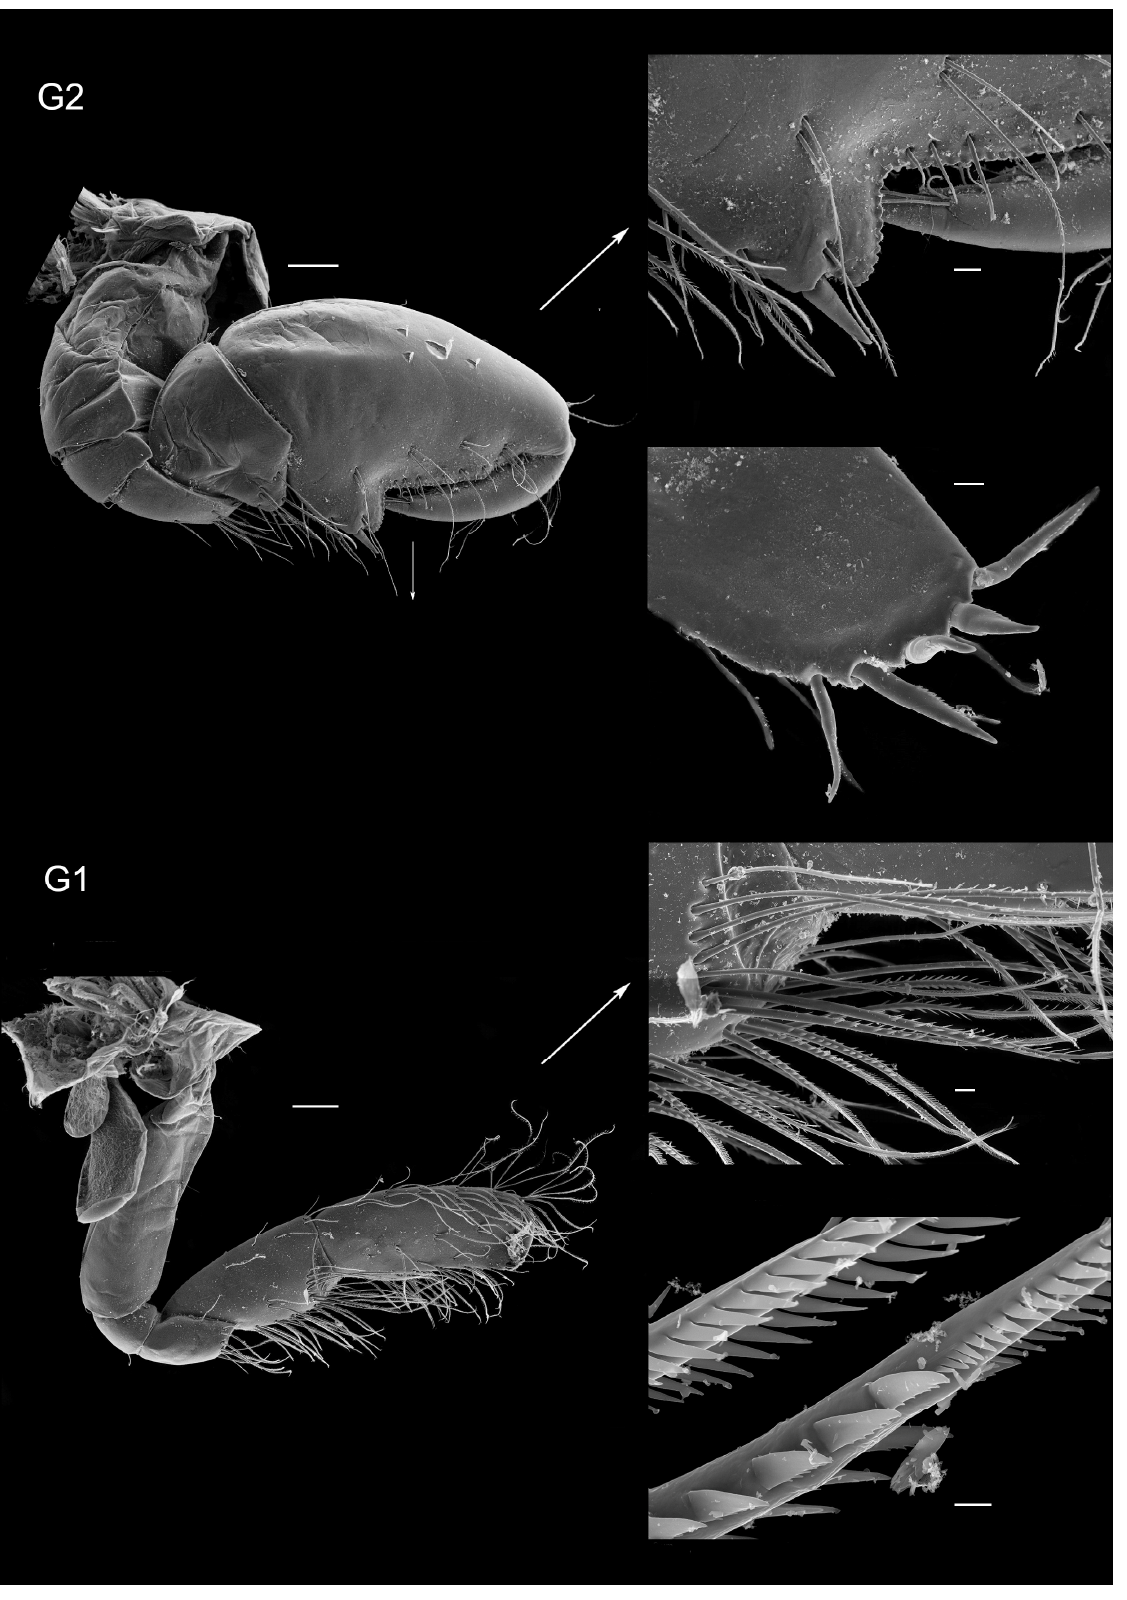
Figure 18. Unciola icelandica sp. nov. SEM image, paratype female, 6 mm, ZMHK-56725, South Island, Iceland Basin, 1921 m. Scales: gnathopod 1 and 2–100 µm, dactylus tip 20 µm.